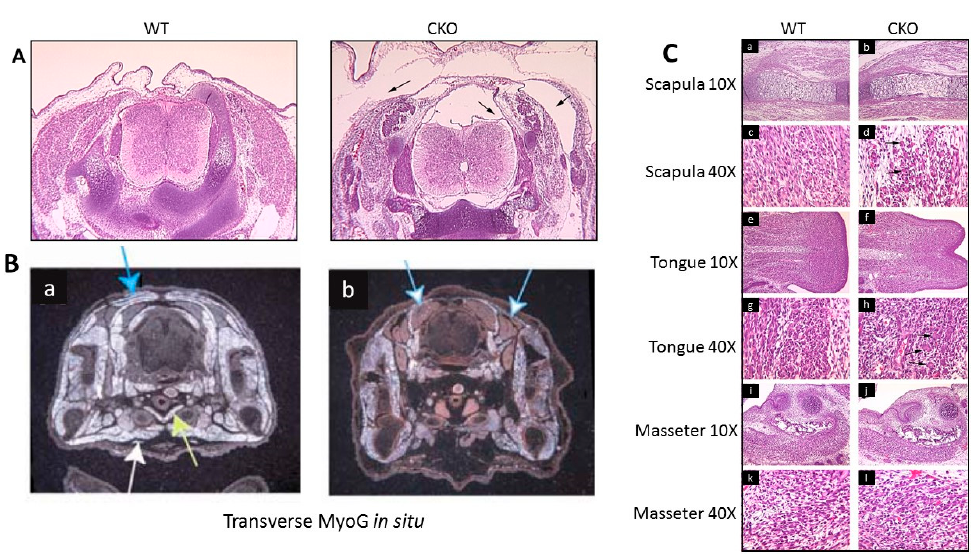
Figure 2. Skeletal muscle development in the MyoG-Cre -induced Smyd1 CKO is significantly derailed. ( A ) Haematoxylin and Eosin (H&E)-stained transverse sections of E14.5 WT and CKO embryos stained with H&E. Marked subcutaneous edema is most visible in the cervical region (arrows). ( B ) Myogenin in situ hybridization of WT and CKO transverse sections reveal reduction of myocytes and general affliction of some, but not all, muscles. The pectoral (white arrow) and sternohyoid (yellow arrow) muscles did not develop in the CKO; the dorsal muscles (solid blue arrow) are significantly diminished, but other muscles (e.g., limbs) are clearly less afflicted, if at all. There is an excess of tissue tentatively classified as brown adipose tissue (blue and white arrows) in the CKO. ( C ) H&E stains ( a – h ) of WT and CKO sections at E15.5. Scapulae ( a – d ) show asynchronous elongation and emergence of large, multinucleated cells—myoblasts that did not fuse—but failed to elongate into myotubes (black arrows in d ). Stains of CKO tongues ( e – h ) displayed the same phenotypes as above with evident multinucleated, unfused structures (black errors in h ). CKO masseter muscles ( i – l ) had no observable morphologic defects.